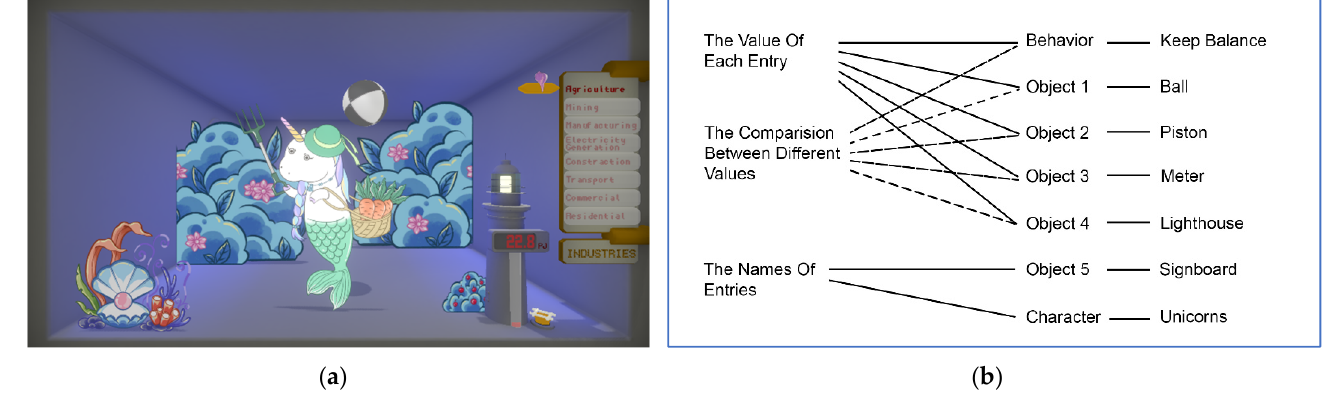
Figure 9. Initial prototype and its information mapping. ( a ) The screenshot of the prototype; ( b ) the information mapping of the prototype.